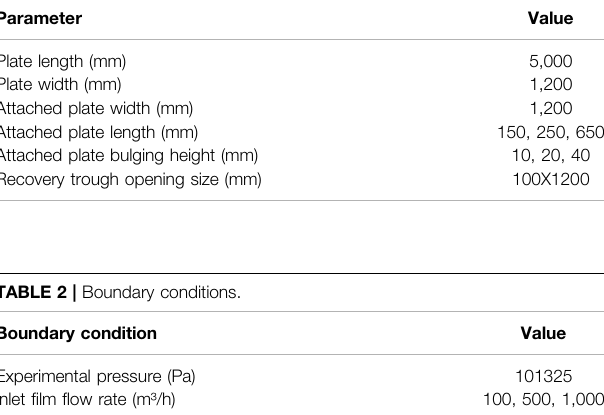
TABLE 1 | The geometric dimensions of the 3-D